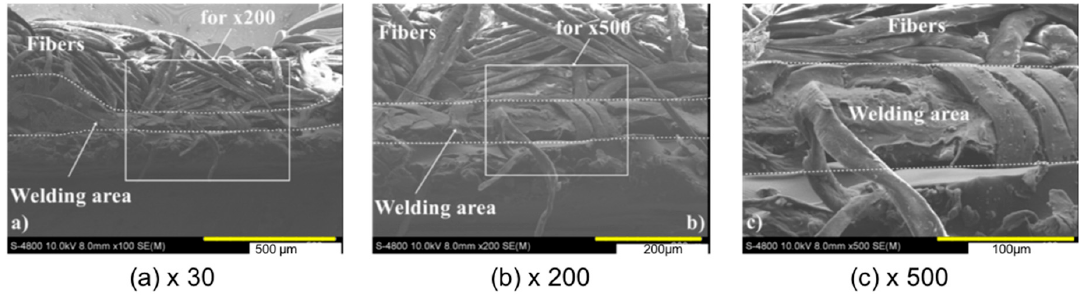
Figure 10. SEM images of the ultrasonic welding joints taken at a cross-section with magnification of ( a ) ×100, ( b ) ×200, and ( c ) ×500.